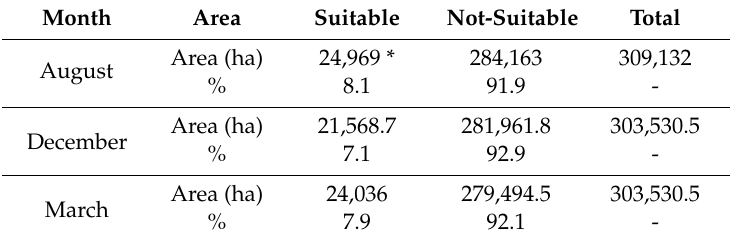
Table 3. Summary of the predicted suitable and not-suitable areas for water hyacinth growth. Month Area Suitable Not-Suitable Total Area (ha) 24,969 August